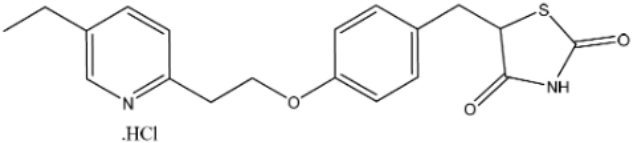
Figure 1. Chemical structure of pioglitazone